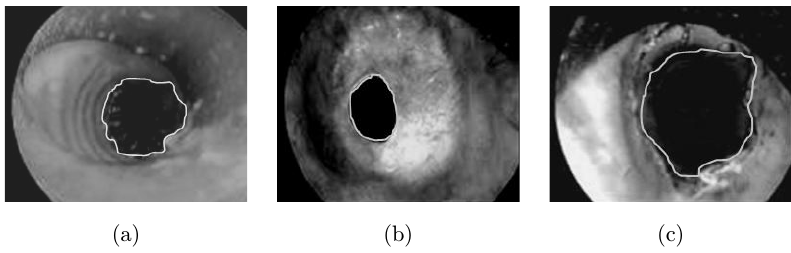
Fig. 5. Representative images of the primary bronchus with the area of bronchus opening assessed by the image-based method. The bronchus was imaged by the °exible ¯ber optical nasopharyngoscope, and the area of the bronchus opening was identi¯ed (outlined by the while line) and computed by the image processing and analysis algorithm. (a) (cid:1) (c) displays the area of bronchus opening during normal tidal breathing, 5 min after the last dose of histamine challenge, and 5 min after albuterol treatment (2.5mg/ ml) following 30 min waiting time at the end of the last dose histamine challenge,